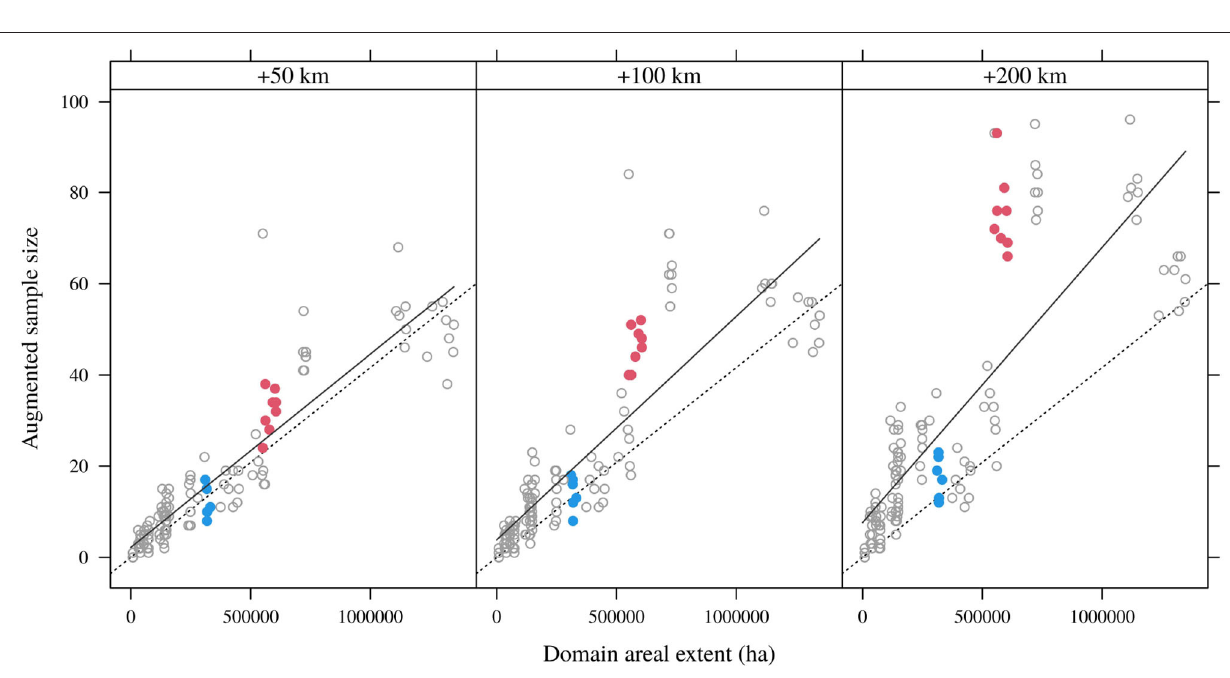
estimated standard errors of indirect estimates were larger